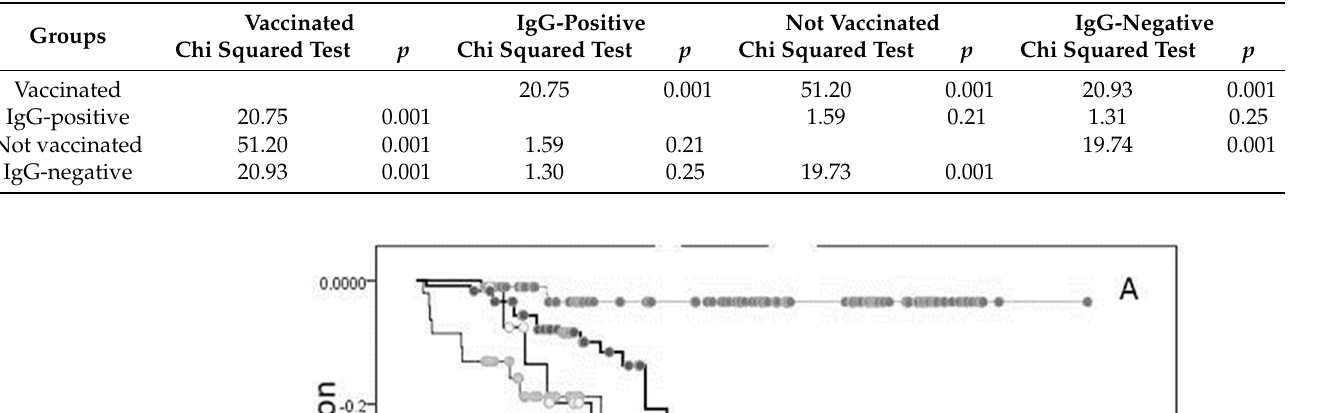
Table 4. Pairwise comparisons of the groups of respondents with various vaccination and IgG statuses according to Kaplan–Meier analysis (Log rank Mantel–Cox test).